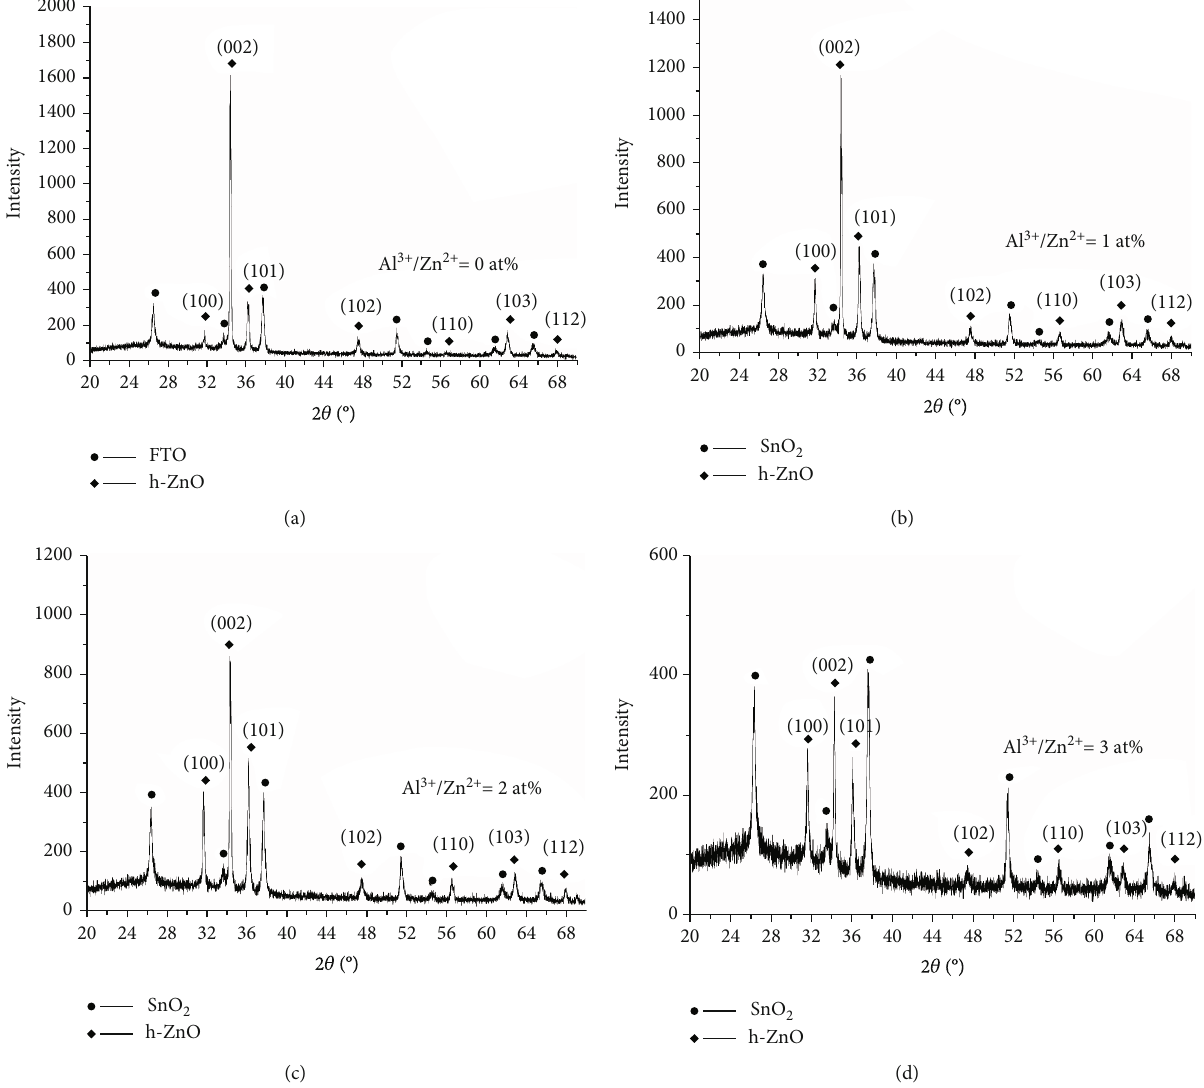
) with di ff erent Al 3+ /Zn 2+ ratio in the bath: (a) 0 at%, (b) 1 at%, (c) 2 at%, and (d) 3 3